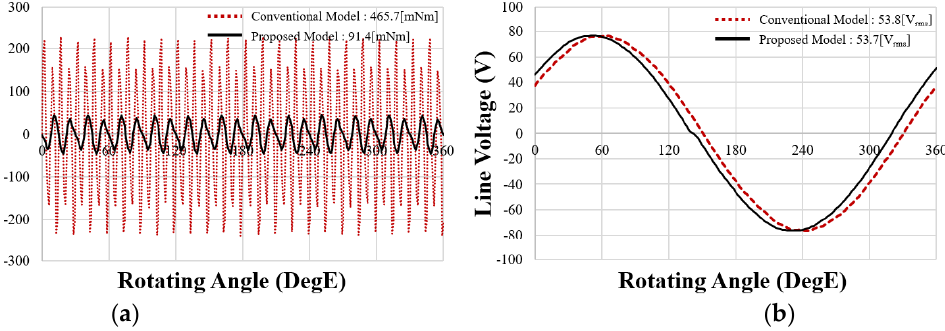
Figure 14. Comparison of the conventional and proposed models ( a ) cogging torque, ( b ) line voltage.